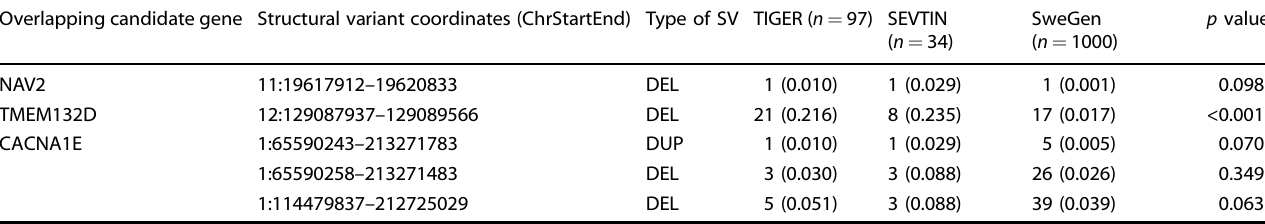
Table 2. SVs overlapping genes enriched in LoF and missense variants in SEVTIN and TIGER cohorts. Overlapping candidate gene Structural variant coordinates (ChrStartEnd) Type of SV TIGER ( n = 97) SEVTIN